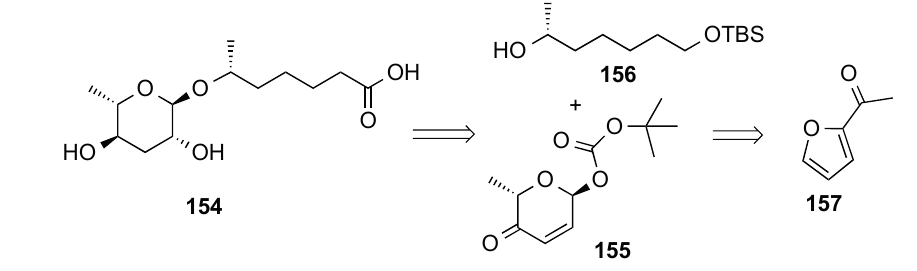
Scheme 34. Pd-catalyzed stereoselective glycosylation.